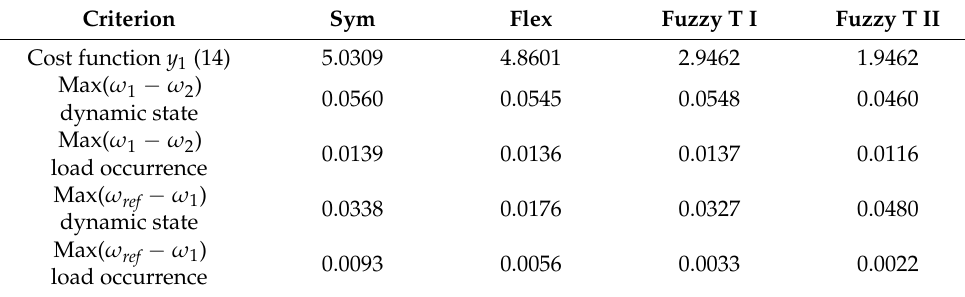
Table 1. The comparison of numerical quality indicators for different controllers.